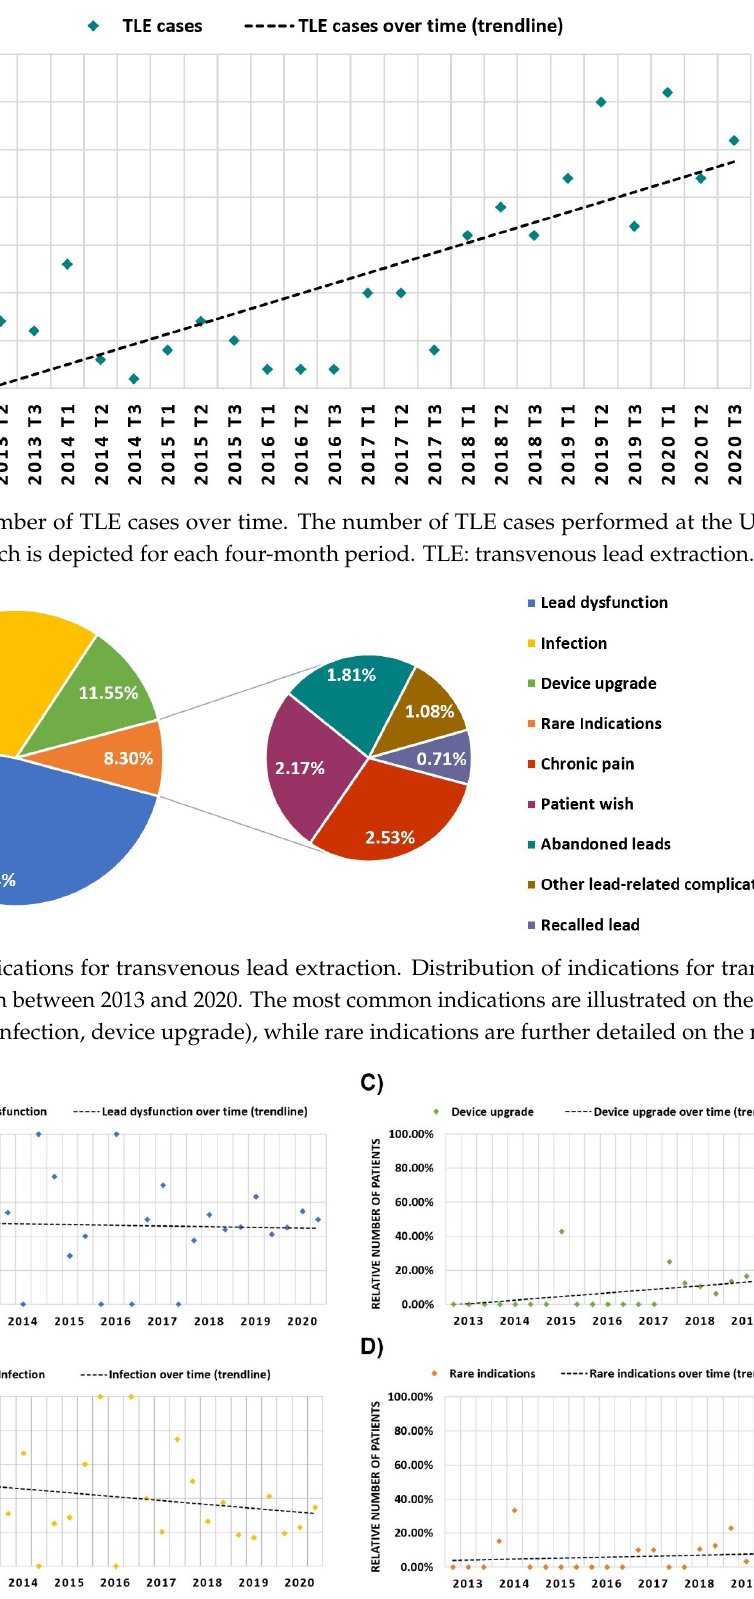
Figure 3. TLE indications over time. The relative number of patients requiring TLE due to lead dysfunction ( A ), infection ( B ), device upgrade ( C ), and rare indications ( D ) over time. Data is demonstrated for every four-month period including trendline analysis.